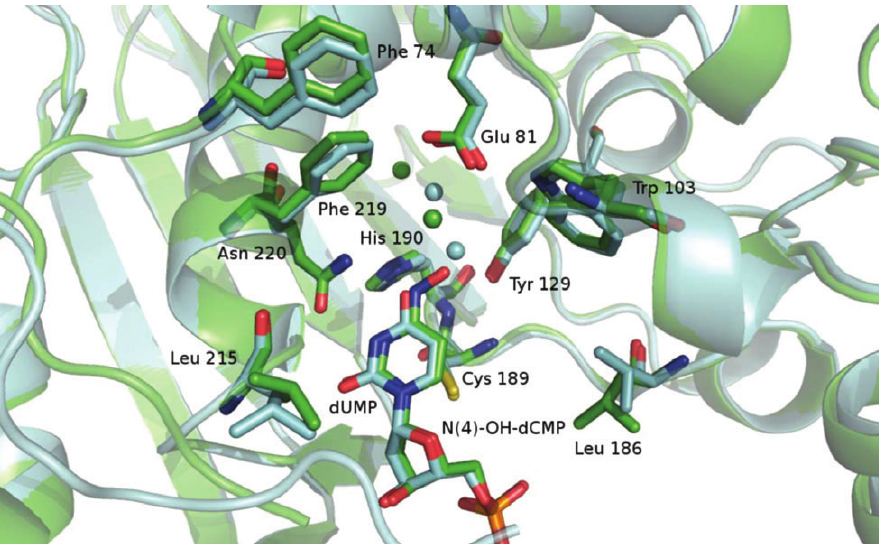
Figure 3 Differences in the active site arrangements in mTS-N 4 -OH-dCMP (green) against mTS-dUMP (cyan). Shown are N 4 -OH-dCMP, dUMP, several amino acids and a few ordered water molecules.